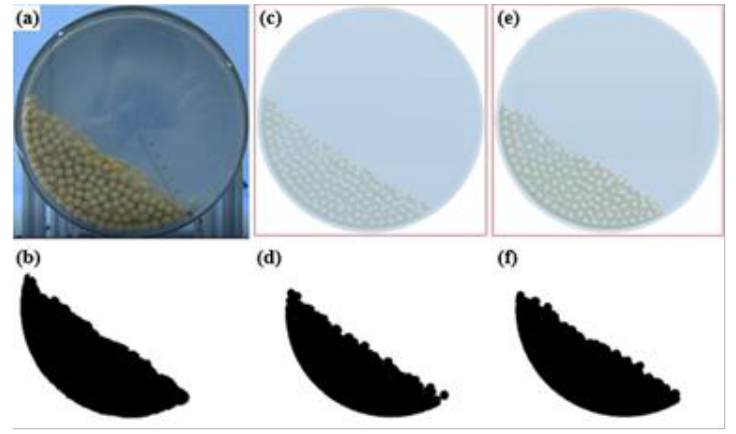
Figure 18. ( a ) The test photo of the rotating cylinder and ( b ) its binarization image; ( c ) simulation result snapshot using calibration parameters and ( d ) its binarization image; and ( e ) simulation result snapshot without considering rolling friction coefficient and ( f ) its binarization image.